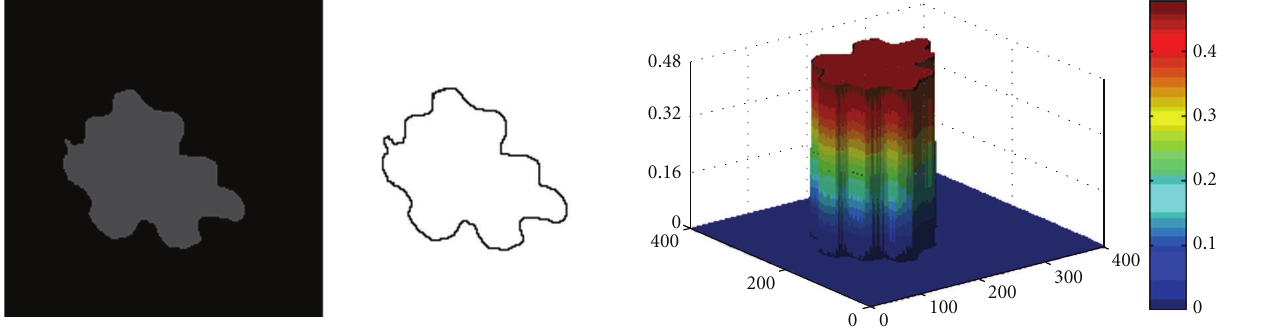
Figure 2: Test 1: The 3D visualization of the segmentation function u ( τ , x ) at steady state T = 0 .